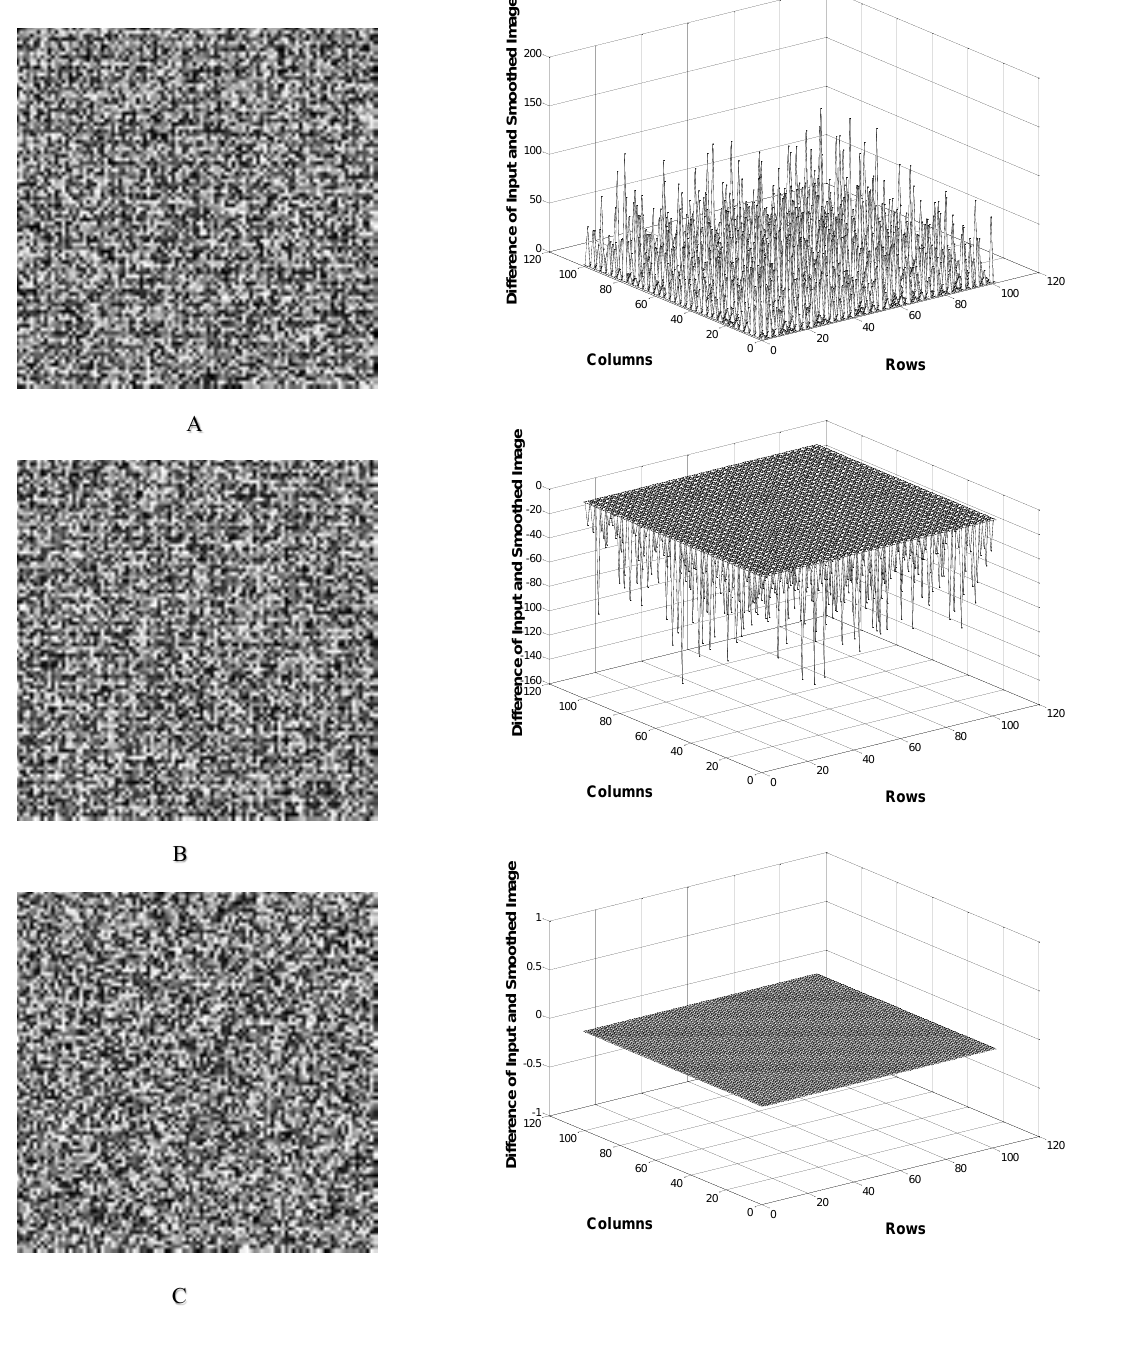
Figure 5 Test Images and Evaluation of Robust Filtering